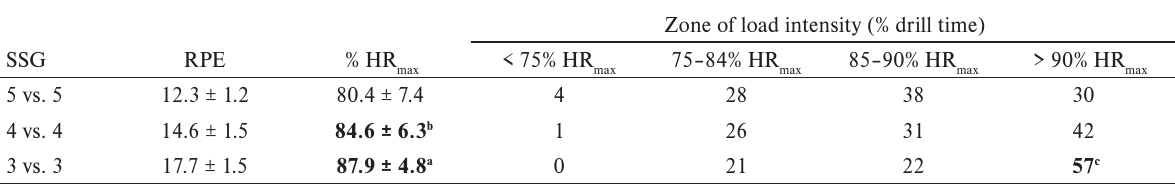
Note. SSG = small sided games, RPE = Rated Perceived Exertion scale. a significant difference between SSG 3 vs. 3 and 5 vs. 5 ( p = .035); b significant difference between SSG 4 vs. 4 and 5 vs. 5 ( p < .001); c significant difference between SSG 3 vs. 3 and 5 vs. 5 ( p = .041). Bold face indicates a significant difference.